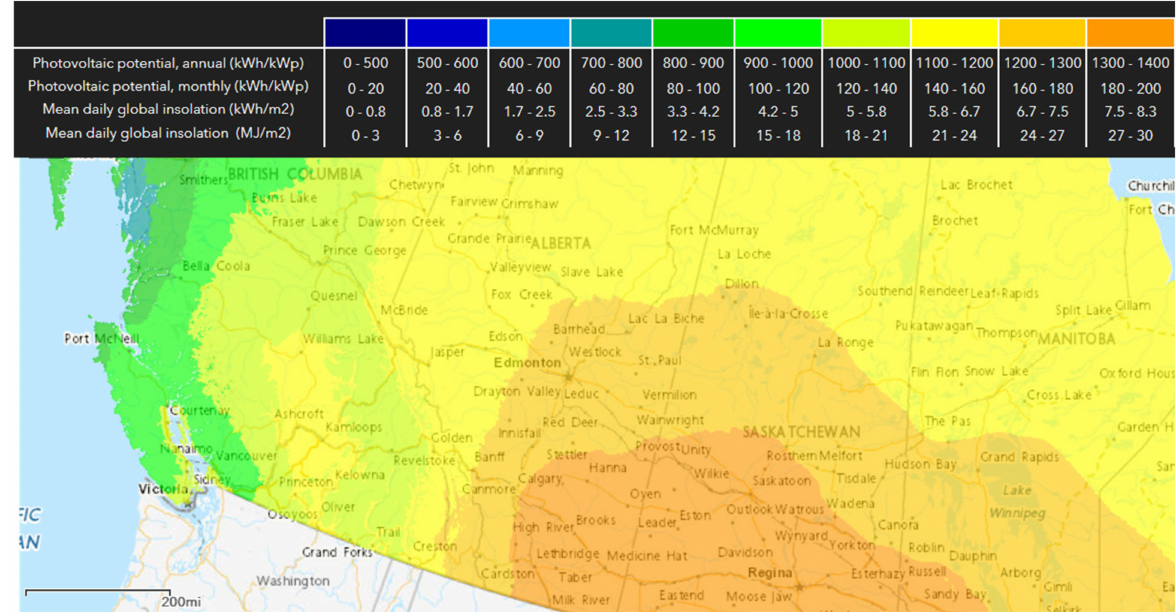
Figure 2. Annual solar photovoltaic potential in kWh/kWp facing south with a latitude tilt in Alberta